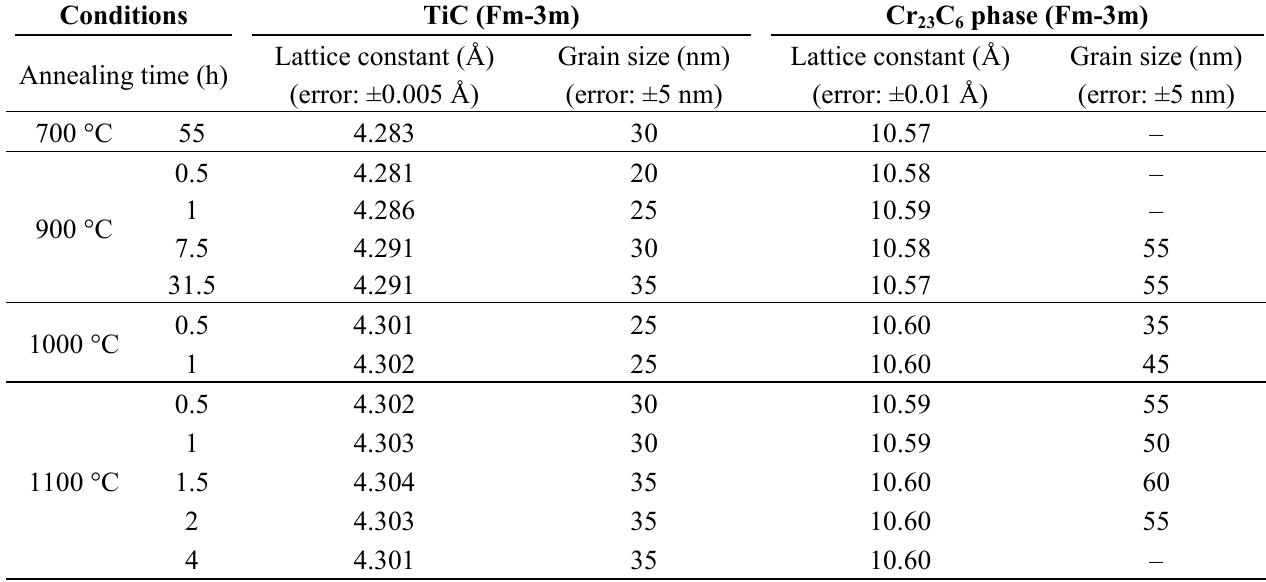
W )B coatings determined 0.49 0.51 2